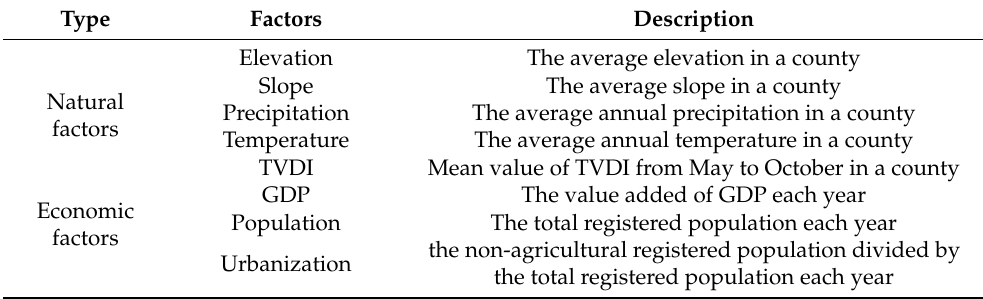
Table 1. Descriptive statistics of independent variables of land-use